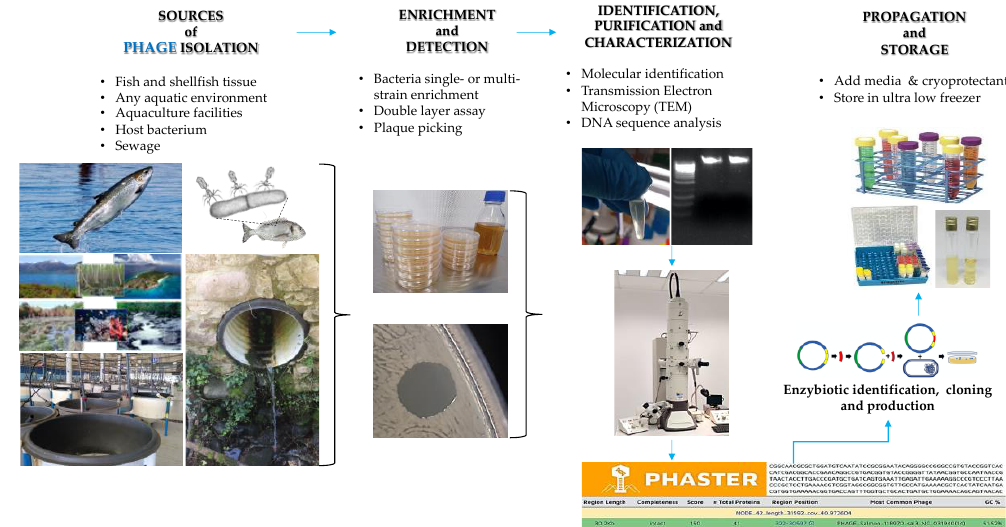
Figure 2. Schematic steps followed for the isolation and characterization of phages intended for use in aquaculture. From left to right: General steps for phage isolation, enrichment, detection, identification, characterization, propagation, and storage.